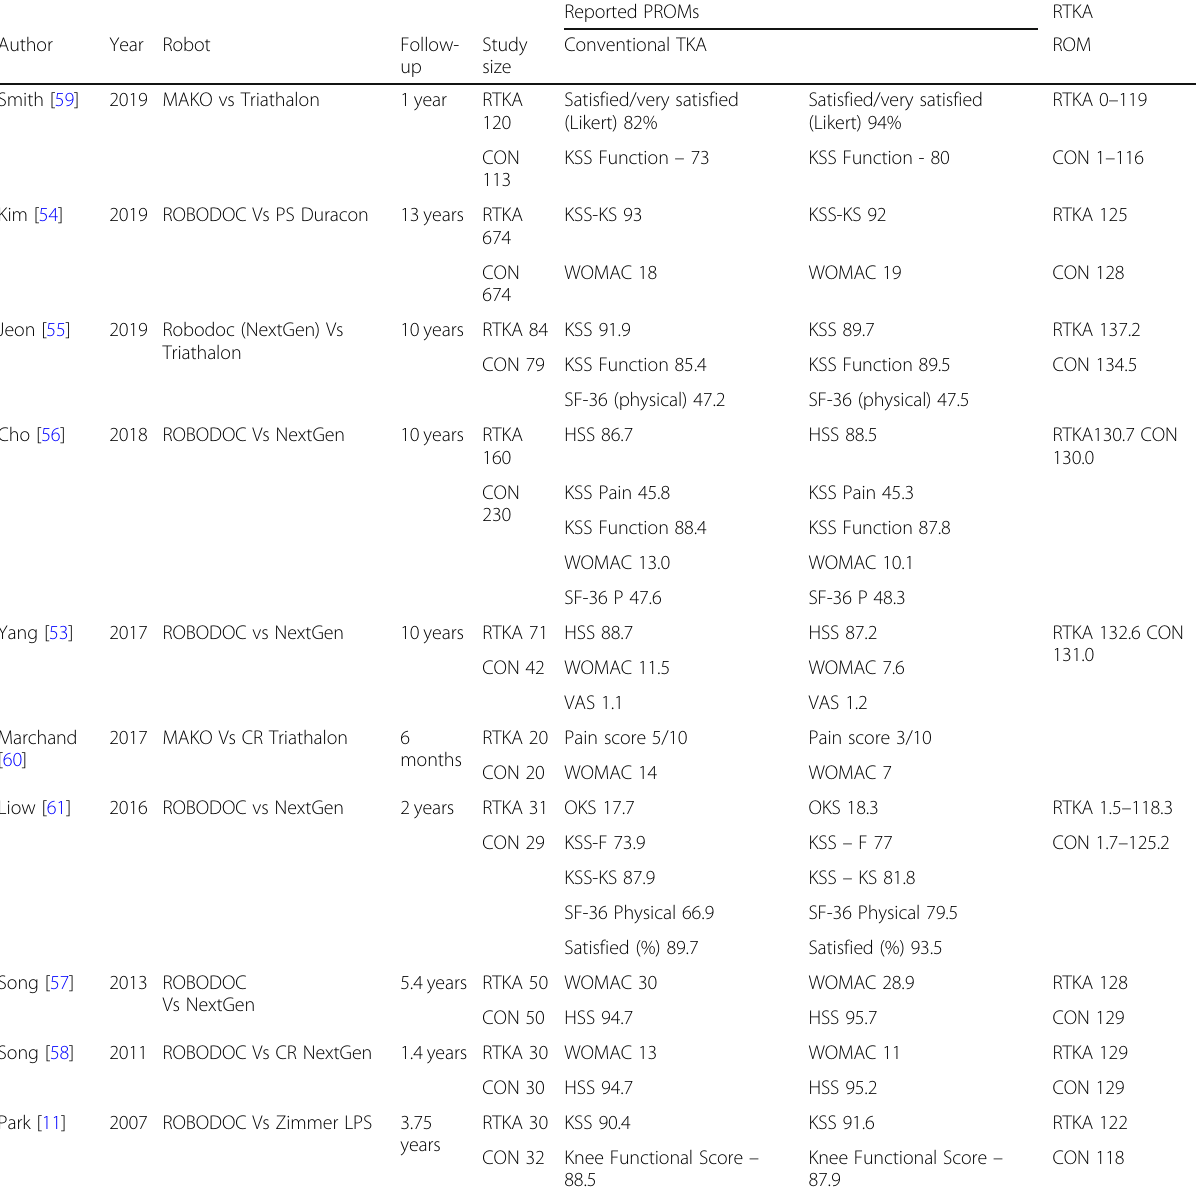
Table 4 Robotic TKA versus Conventional TKA PROMs